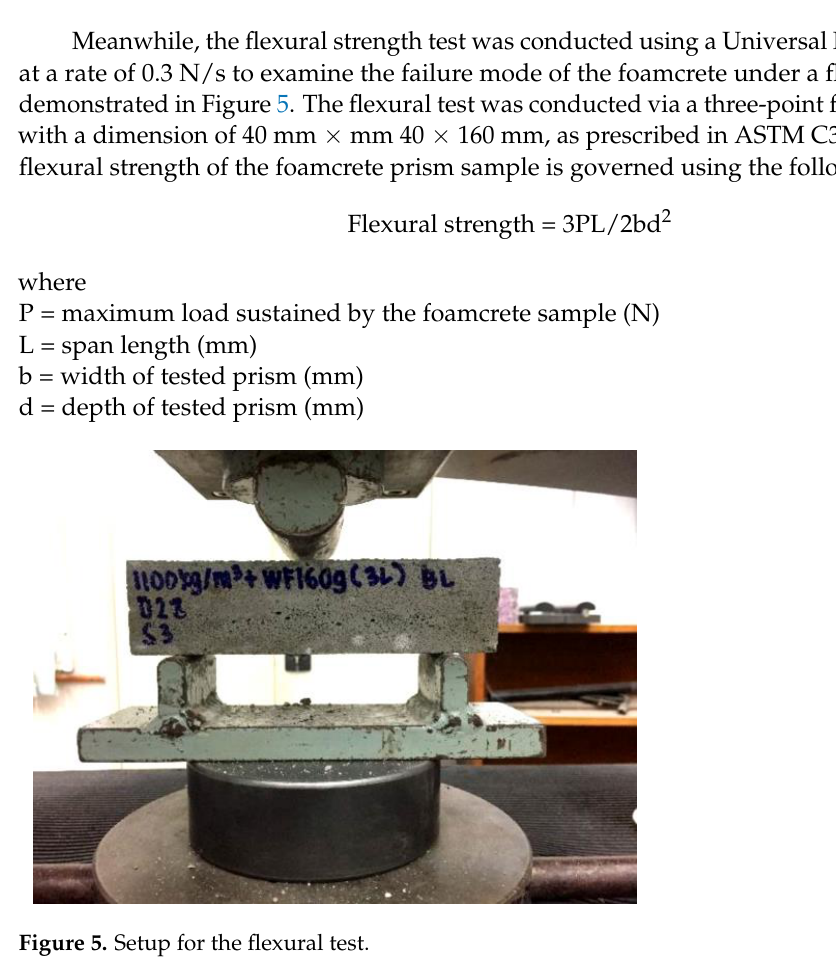
Figure 4. Setup for compression test.